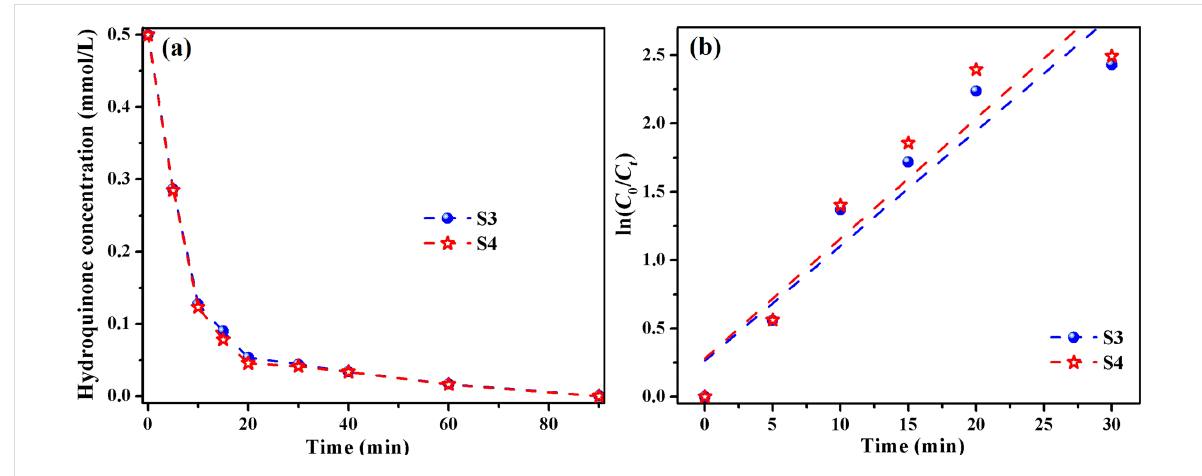
Figure 9: Temporal evolution of the hydroquinone concentration (a) and fitted curves for the kinetic estimation of hydroquinone photodegradation (b) under visible light in presence of S3 and S4 films.